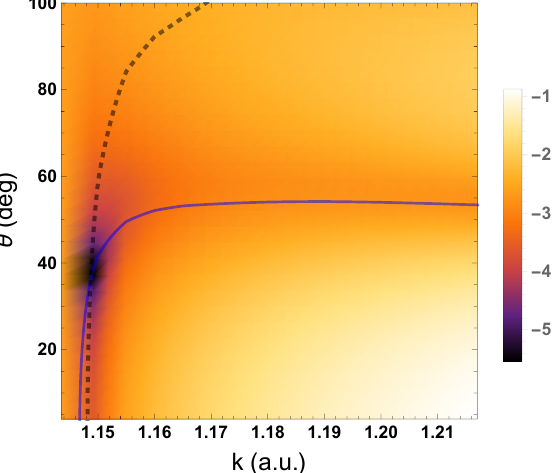
Figure 1. Density plot of the common logarithm of the Ps-formation differential cross section, [ DCS ] , which we compute using the complex Kohn K-matrices as a function of the magnitude log 10 of the momentum of the incident positron, k , and the angle of the outgoing Ps, θ , for positron–helium collisions. The nodal lines of Re [ f Ps ] = 0 and Im [ f Ps ] = 0 are represented by the solid blue line and the dashed black line,